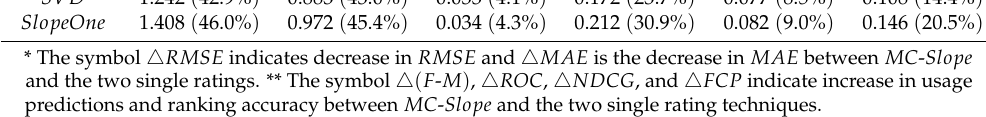
Table 7. Level of accuracy improvement between MC - Slope and the single rating techniques.